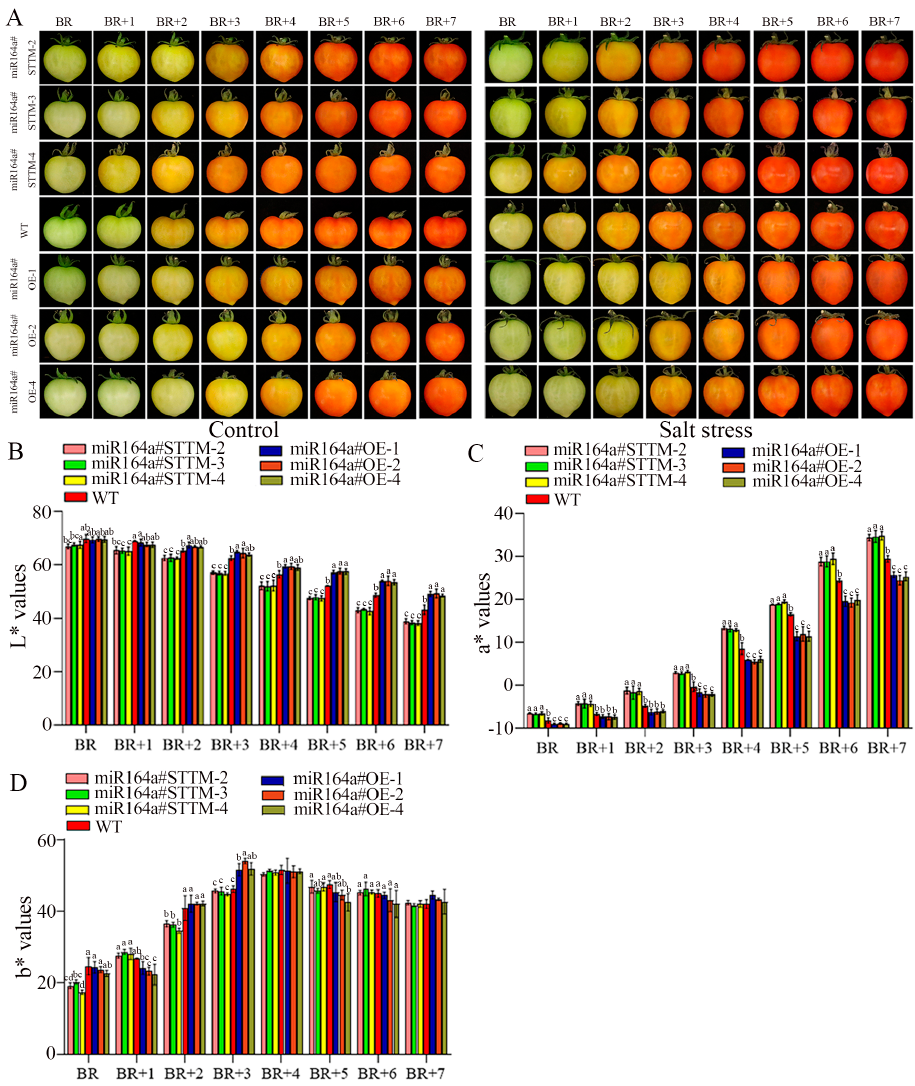
Figure 5. Phenotypes assessment of postharvest fruit of miR164a#STTM, WT and miR164a#OE tomato fruits under control and salt stress. ( A ) Comparison of postharvest fruit development of miR164a#STTM, WT and miR164a#OE tomato under control and salt treatment. Changes of color difference L* value ( B ), a* value ( C ), b* value ( D ) of STTM-miR164a, WT and OE-miR164a postharvest tomato fruit at Br to Br + 7 day under salt treatment. Vertical bars represent standard deviations of the means, n = 3. Different letters indicated significant differences between WT and transgenic tomatoes in the values at p < 0.05. Under 100 mM NaCl stress, the average soluble solids content of miR164a#STTM-2, miR164a#STTM-3, miR164a#STTM-4 and WT tomato fruits were 6.57, 6.40, 6.87 and 5.80, respectively. Compared with the control, the soluble solids content of miR164a#STTM-2, miR164a#STTM-3, miR164a#STTM-4 and WT fruit increased by 14.2%, 13.0%, 21.8% and 6.3%, respectively (Figure 6A). The average lycopene content of miR164a#STTM, WT and miR164a#OE tomato fruits were 373.11, 351.38 and 346.05 mg g − 1 FW, respectively. The lycopene content of miR164a#STTM fruit was 1.06 times that of WT, and that of miR164a#OE was 0.98 times that of WT (Figure 6B). The average content of ASA in miR164a#STTM, WT and miR164a#OE tomato fruits were 79.14, 68.91 and 58.34 mg 100g − 1 FW, respectively. The ASA content of miR164a#STTM fruit was 1.15 times that of WT, and